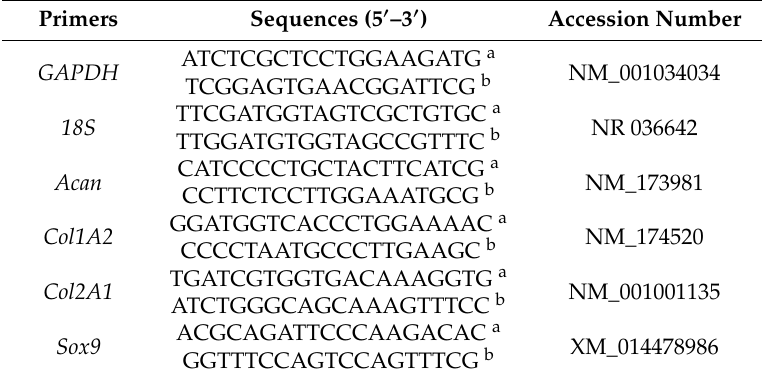
Table 1. Oligonucleotide primers used in this study. Primers Sequences (5 (cid:48) –3 (cid:48)